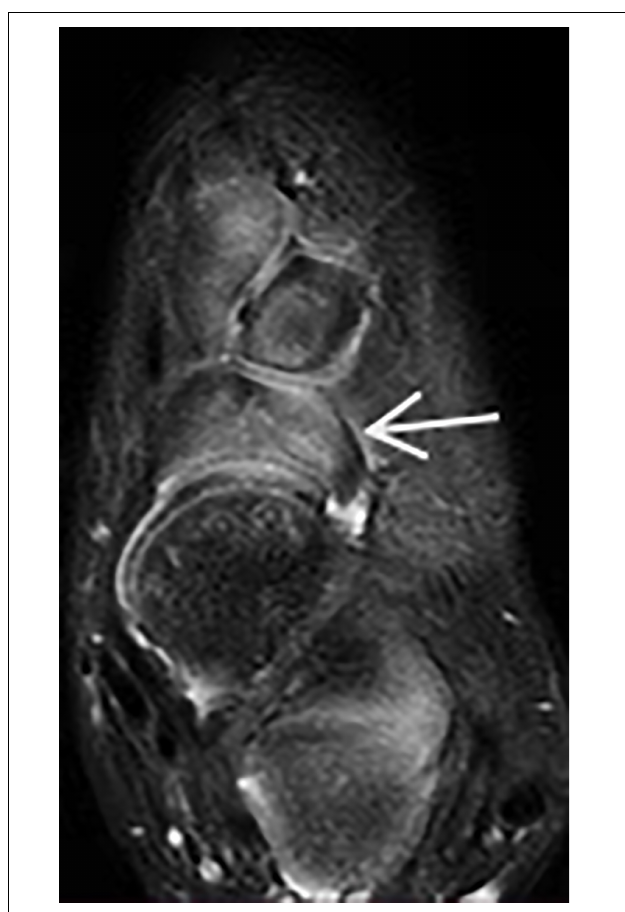
FIGURE 4 | Lateral talonavicular subluxation in the transverse plane of MRI